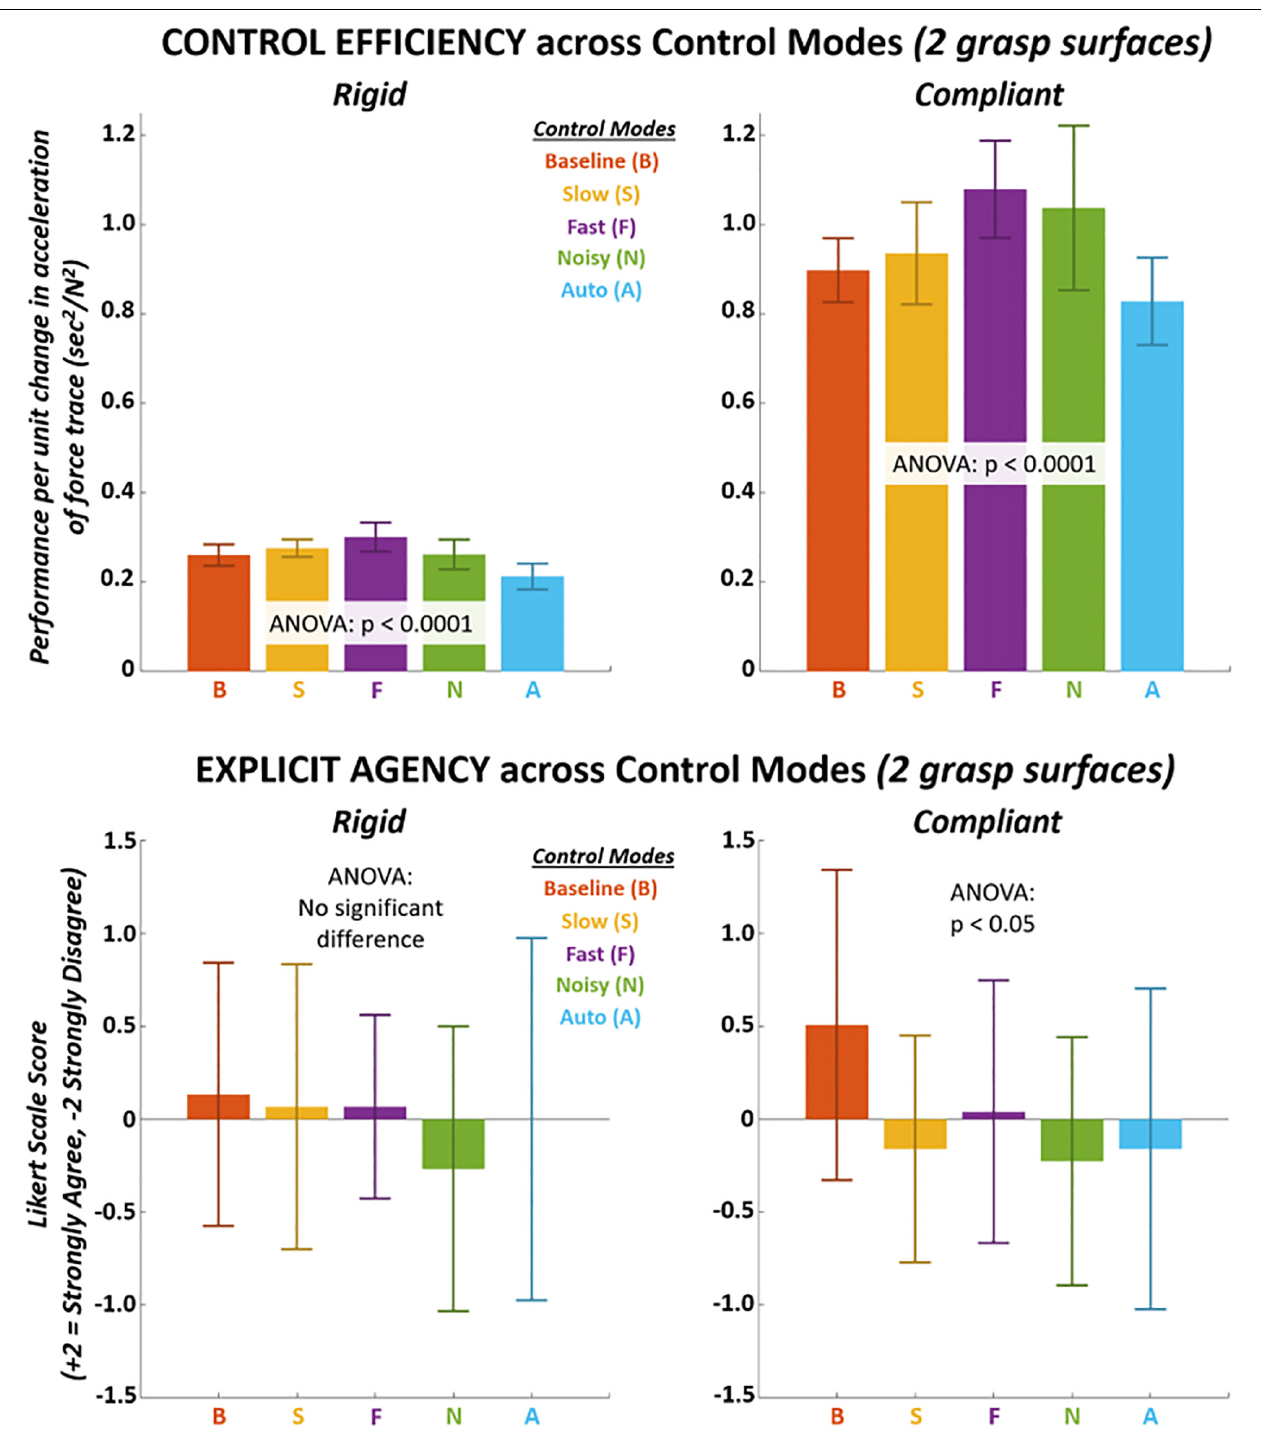
FIGURE 6 | TOP – Mean control efficiency shown for each control mode on each grasp surface. Control efficiency measured as performance normalized by acceleration (2nd derivative) of force trace. BOTTOM – Mean explicit agency shown for each control mode on each grasp surface. Explicit agency measured from survey response along Likert scale: +2 strongly agree, +1 agree, 0 neutral, –1, disagree, –2 strongly disagree . Survey asked participant to what extent they agreed that force trace movements reflected their intended actions after a trial-block for each control mode.